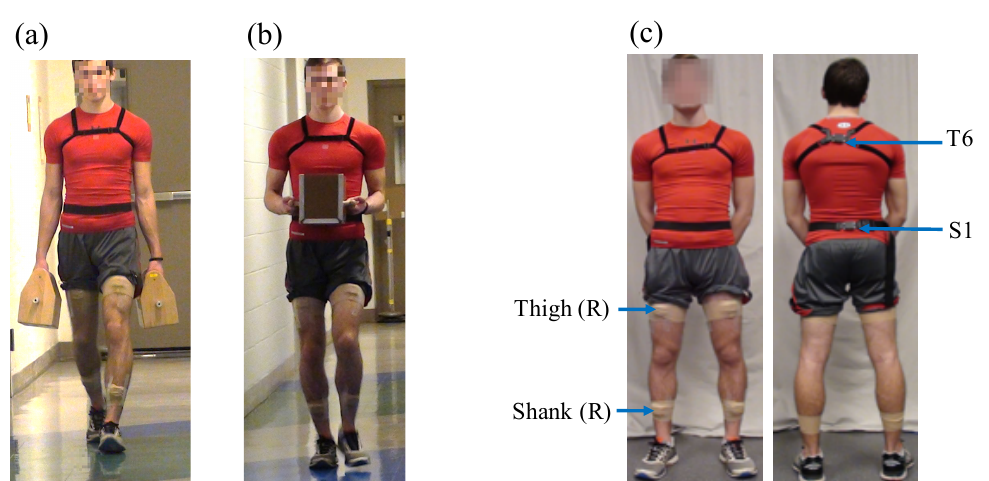
Figure 1. Images showing the two carrying modes evaluated in this study: ( a ) two-handed side carry, ( b ) two-handed anterior carry, along with the location of ( c ) four inertial sensors attached on the body at T6 (Posterior), S1 (Posterior), thigh (Right), and shank